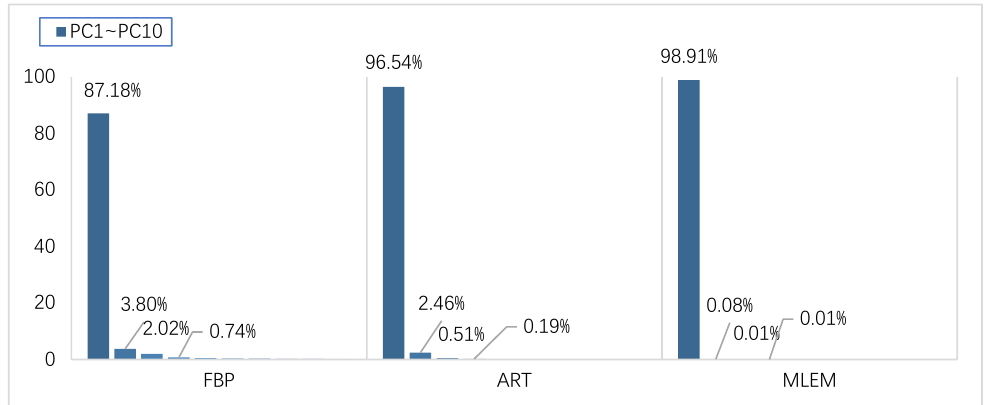
Figure 11. The first 10 principal component contribution rates of three kinds of reconstruction algorithms.